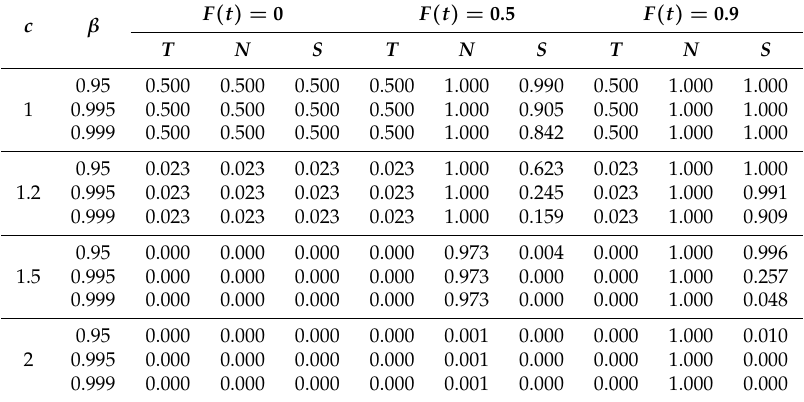
Table 2. Functions H and proportion of unobserved data F ( t ) . (The sample size is n =